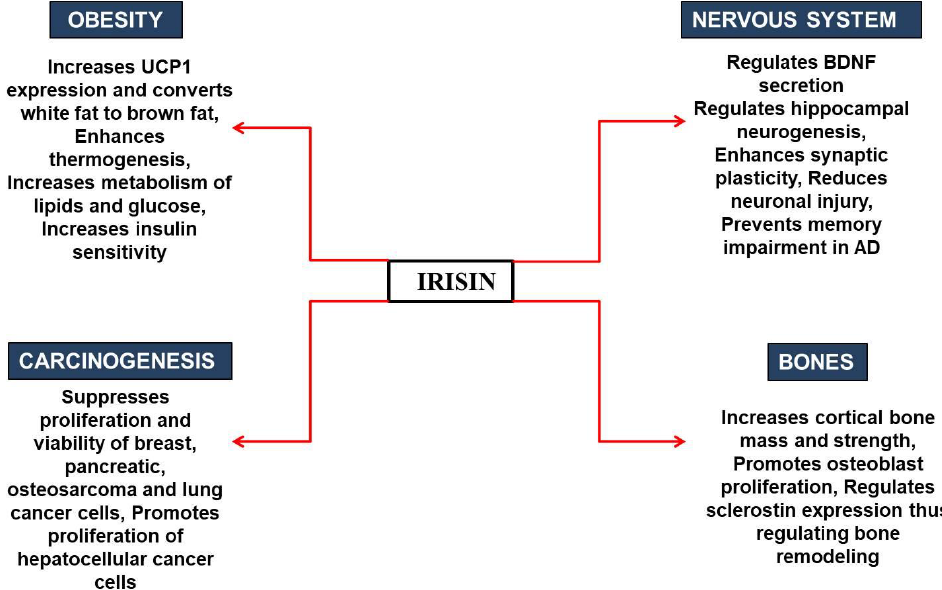
Figure 5. Role of irisin in various physiological